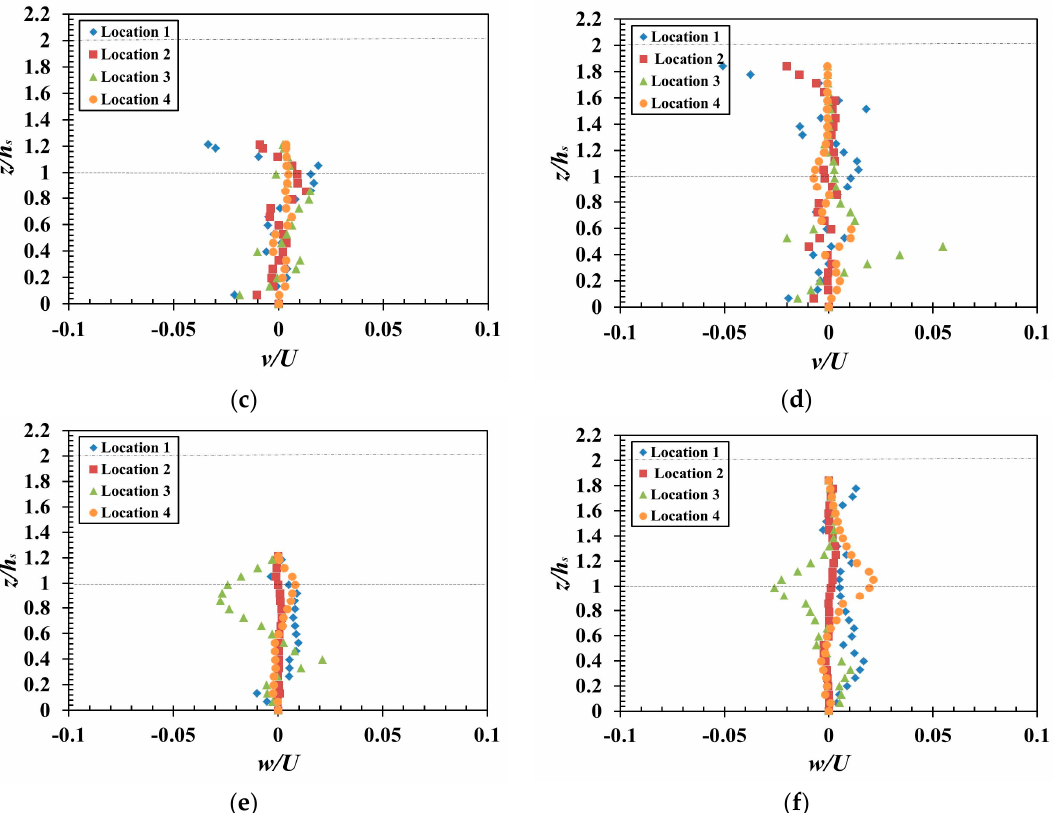
Figure 5. Vertical profiles of mean streamwise ( u ), transverse ( v ), and vertical ( w ) velocities at critical locations (1, 2, 3, and 4) for Case A ( a , c , e ) and for Case B ( b , d , f ). For the definition of the four critical locations, see Figure 3c.